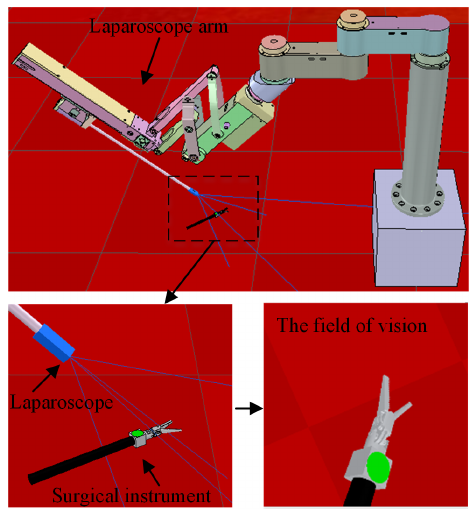
Table 2. Success rate in different test scenarios